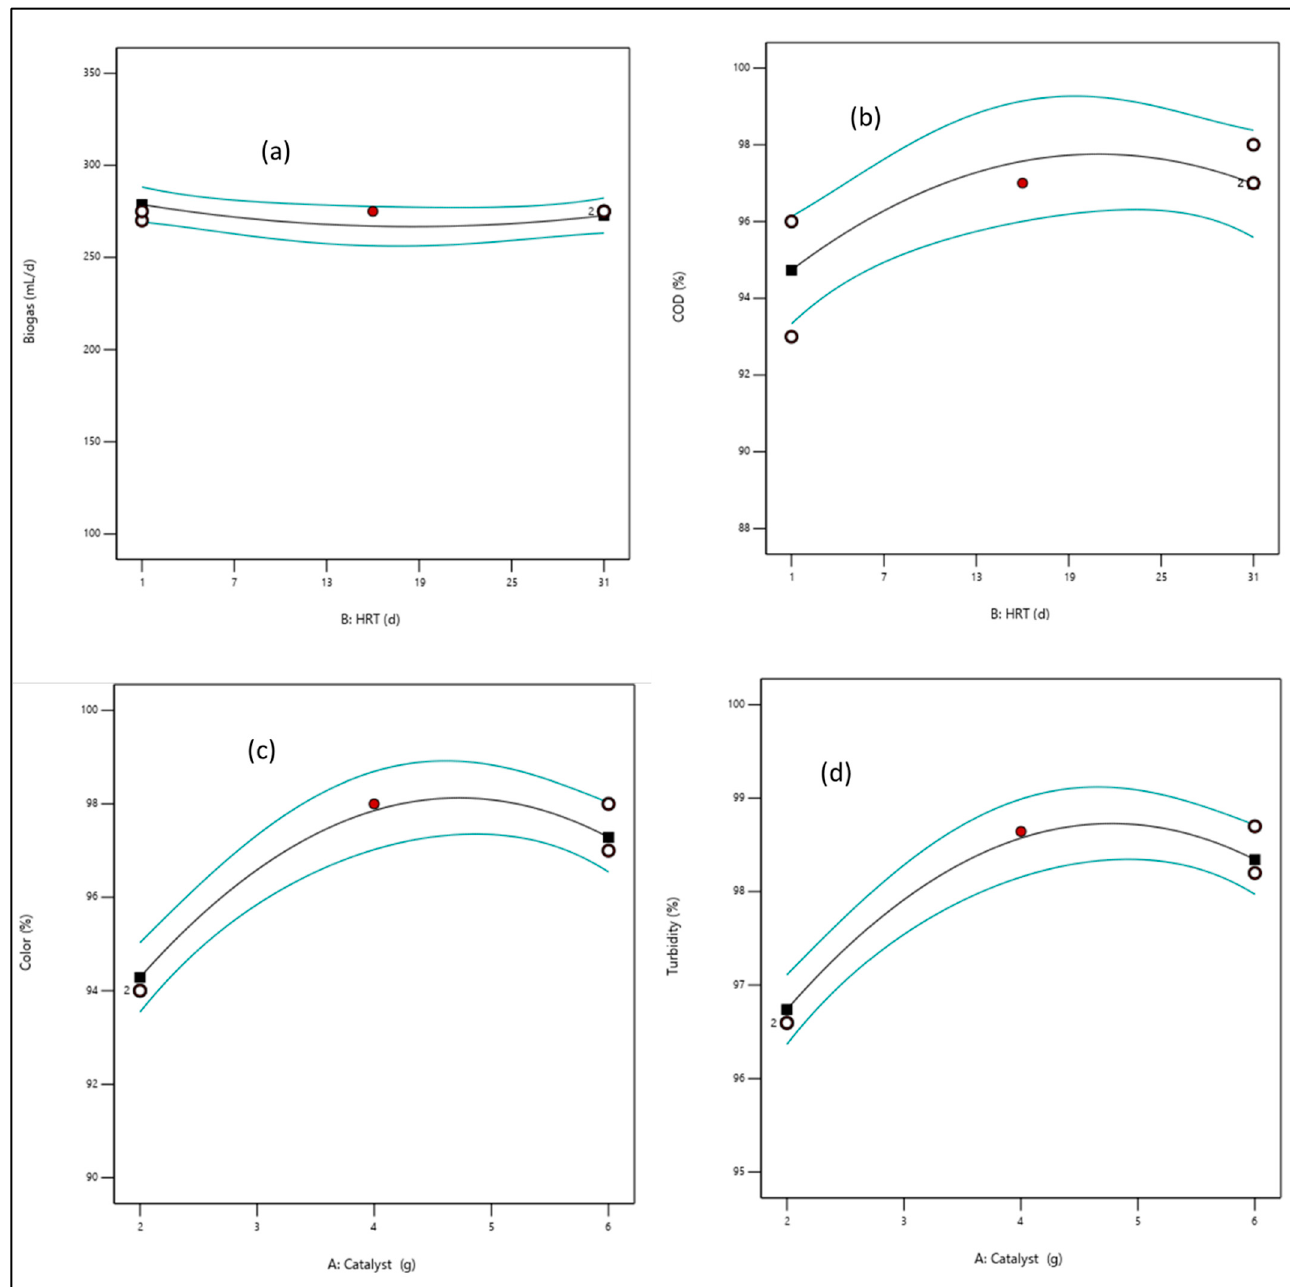
Figure 6. A diagnostic plot of the effect of catalyst load (2–4 g) on ( a ) biogas, ( b ) COD, ( c ) color, and ( d ) turbidity. The blue lines are the threshold or region of the response. The black is the attend line of the response. The whites and black circles are the level points of the response, whereas the red shows the high levels point.